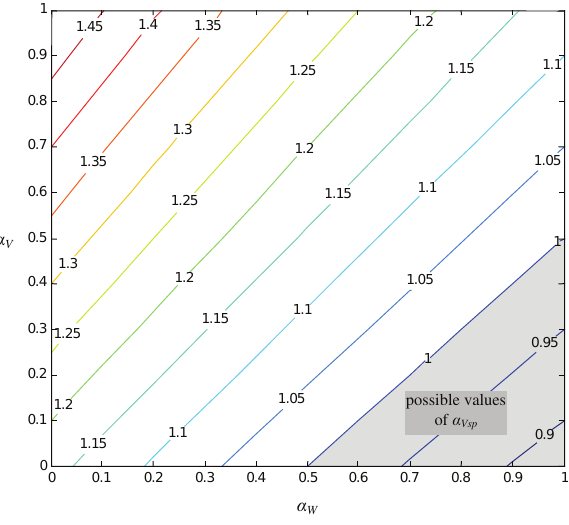
Fig. 17. Contour plot of the function V sp = f ( α W , α V )